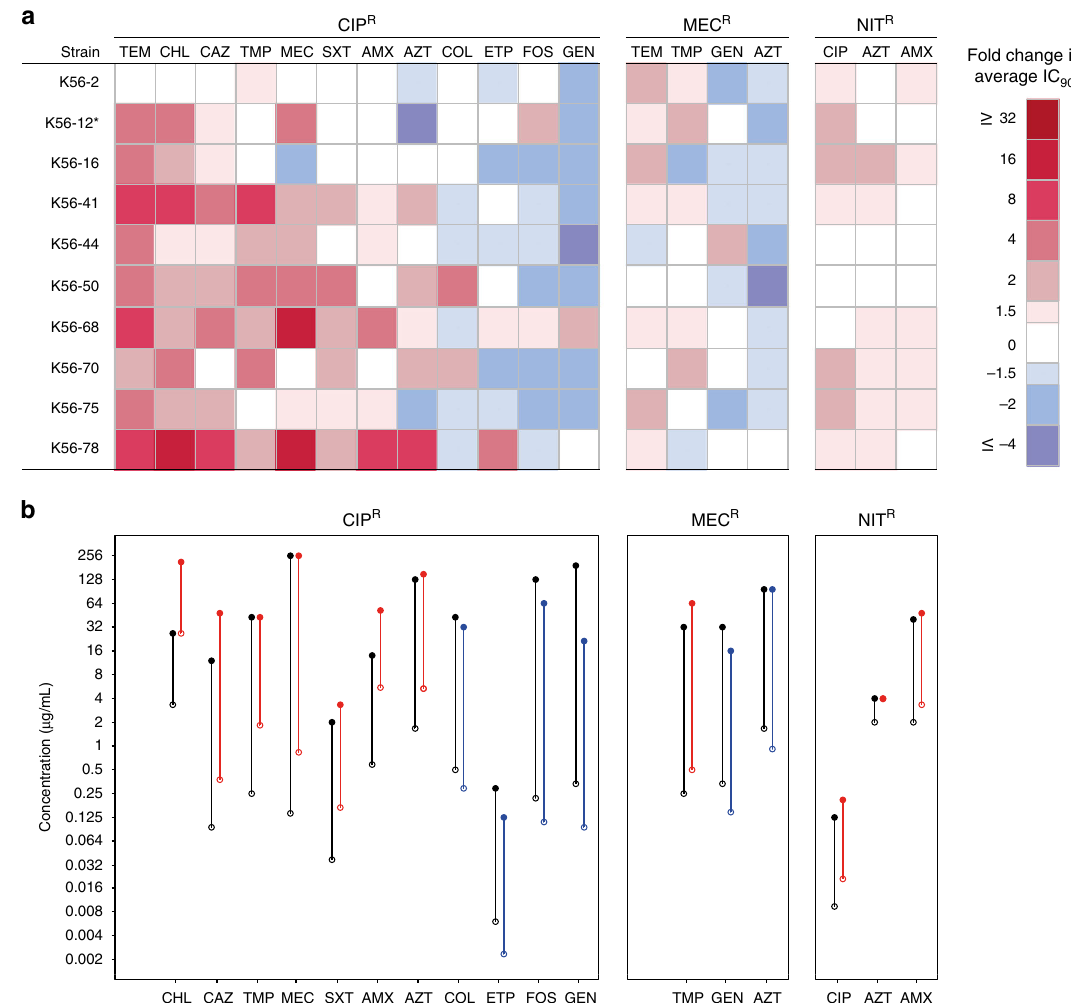
Fig. 1 Conserved collateral responses in antimicrobial resistant mutants. a Relative change in antimicrobial susceptibility was determined by comparing average IC 90 values of resistant mutants to the respective wild-type strain. Collateral responses that were found in ≥ 50% of the strains are displayed, excluding CR observed in all trimethoprim-resistant mutants to trimethoprim-sulfamethoxazole (see Supplementary Fig. 2). Antimicrobials are ordered by most frequent CR (red; left) to most frequent CS (blue; right) for each group. *The slow growing K56-12 CIP R was incubated an additional 24 h for IC 90 determination. b The average IC 90 (open circles) and average mutation prevention concentration (MPC; fi lled circles) were determined and compared between resistant mutants (colored) with collateral responses, either CS (blue) or CR (red), and their respective wild-type strain (black) in strain:drug combinations representing conserved collateral responses, excluding temocillin. The mutant selection window (vertical lines) was de fi ned as the range between IC 90 (lower bound) and MPC (upper bound). K56-16 NIT R had equivalent IC 90 and MPC values for azithromycin, thus no mutation selection window was reported. Generally, changes in MPC values re fl ected observed IC 90 changes, shifting the mutation selection window upwards or downwards accordingly. In 8/10 tested combinations an increase in IC 90 value (CR) from wild-type to resistant mutant correlated with at least a small increased MPC, with the remaining combinations showing no change in MPC value. Similarly, decreased IC 90 values (CS) correlated with decreased MPCs